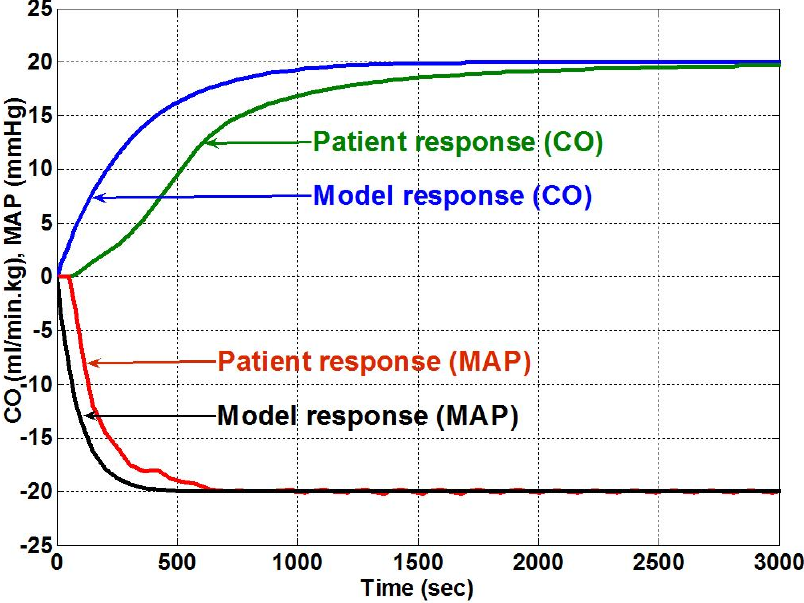
Figure 6: Patient response (CO and MAP), without disturbance, when K 22 = -50